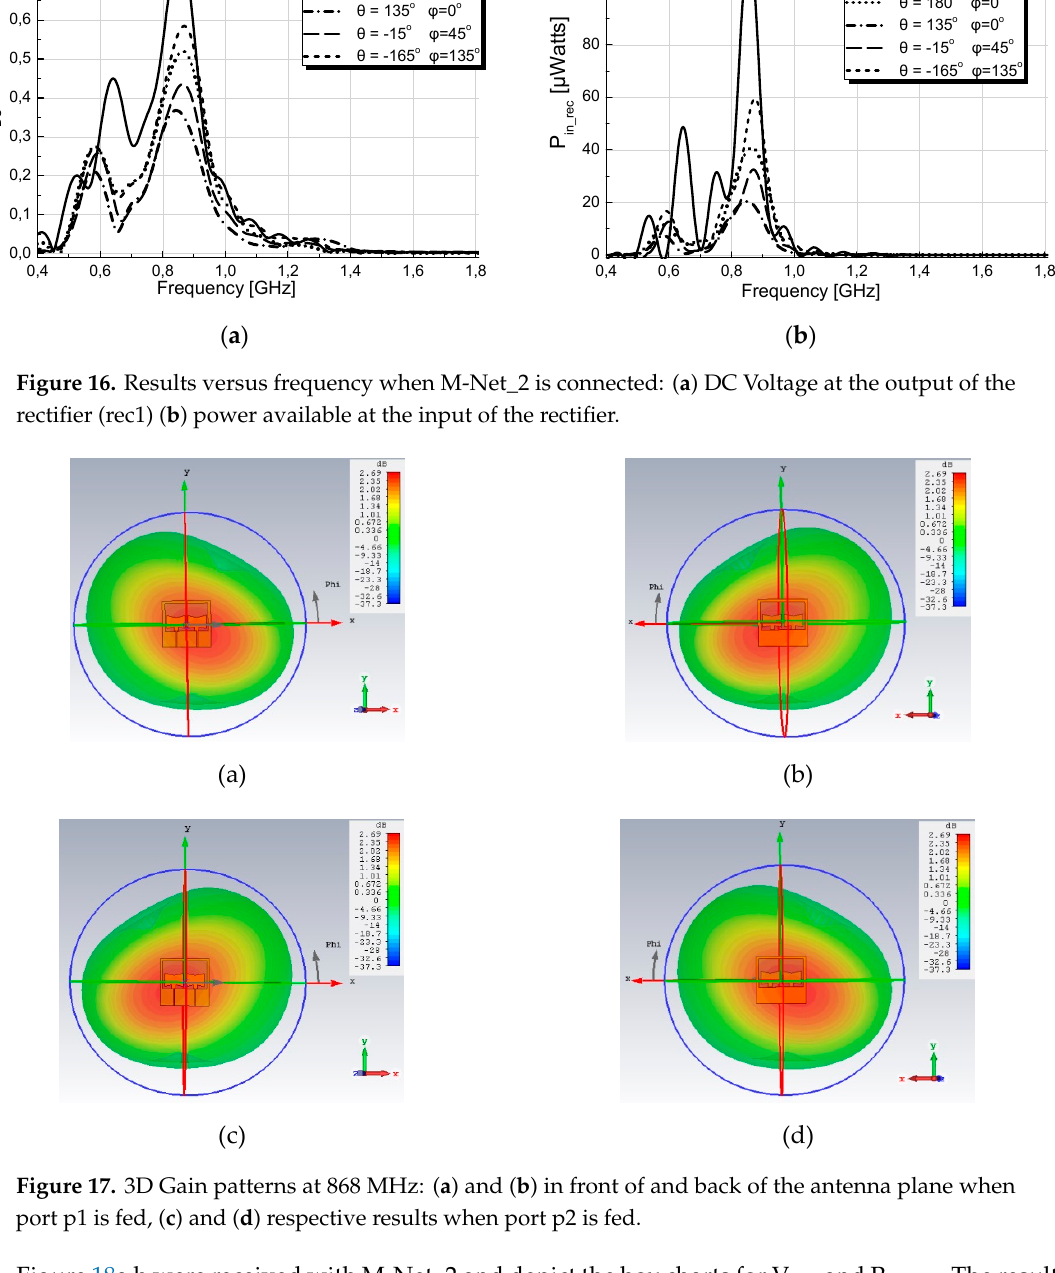
Figure 17. 3D Gain patterns at 868 MHz: ( a ) and ( b ) in front of and back of the antenna plane when port p1 is fed, ( c ) and ( d ) respective results when port p2 is fed.